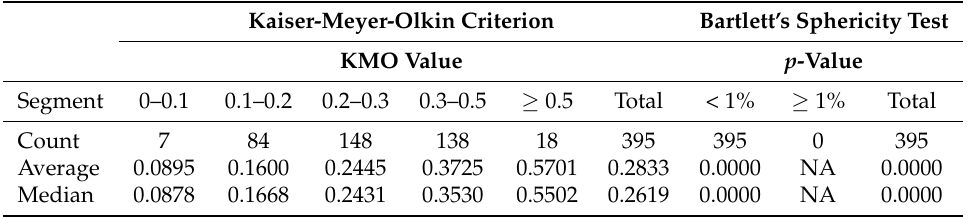
Table 8. Kaiser–Meyer–Olkin (KMO) criterion and Bartlett’s sphericity test results. The KMO values and p -values of Bartlett’s test are segmented into six and three buckets, respectively.